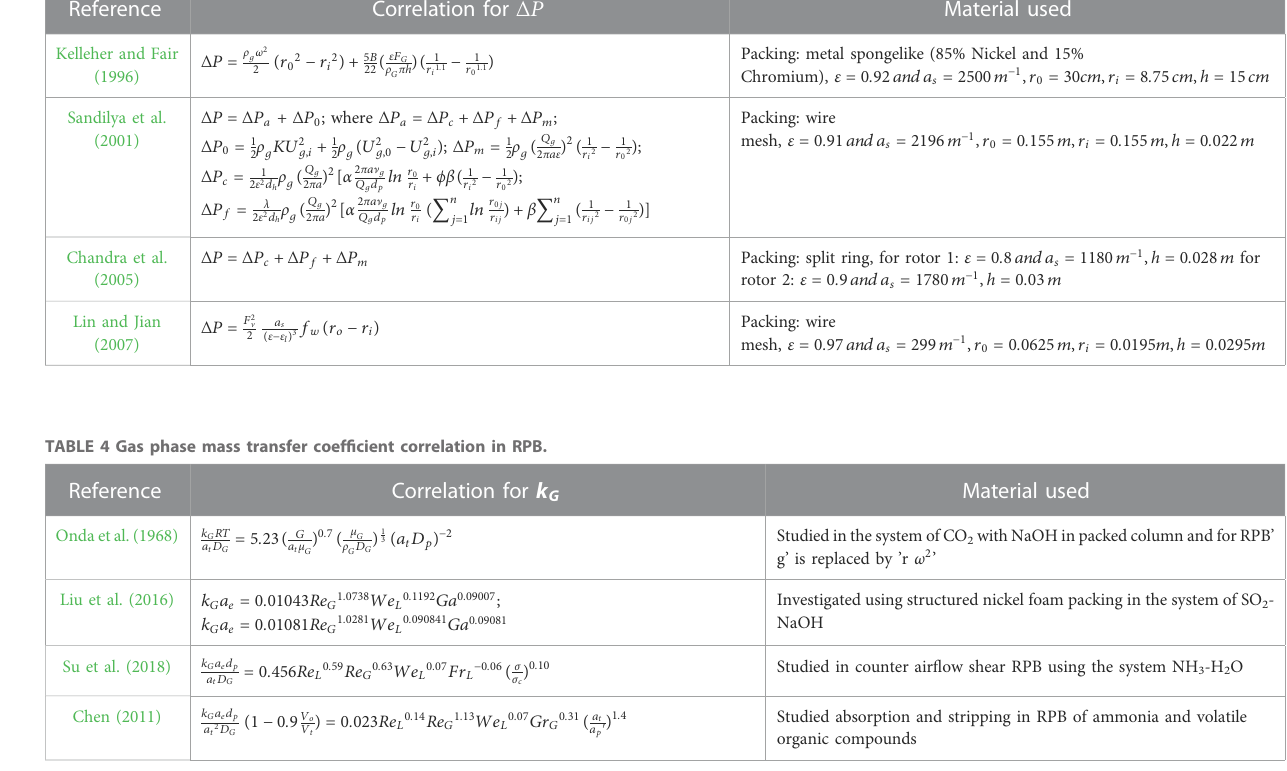
TABLE 3 Pressure drop correlations for RPB Reference Correlation for Δ P Material used Kelleher and Fair (1996)